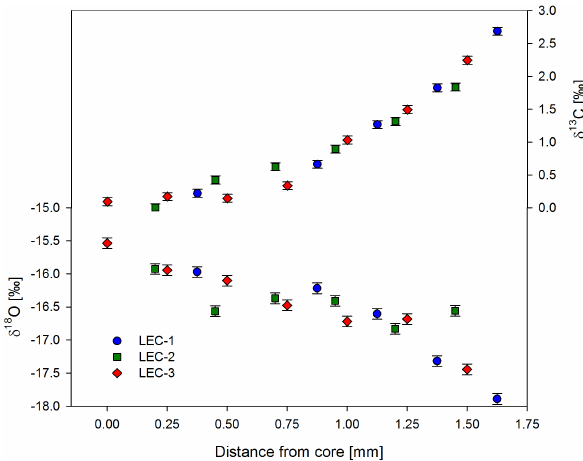
Fig. 5. Stable isotope composition across three individual coarse crystalline cryogenic cave carbonate (CCC coarse ) spheroids from Leclanch´e Cave. The marked negative correlation ( r 2 = 0 . 83) be- tween δ 13 C and δ 18 O argues against kinetic fractionation effects and, accordingly, calcite precipitation is believed to have occurred close to isotopic equilibrium with the parent